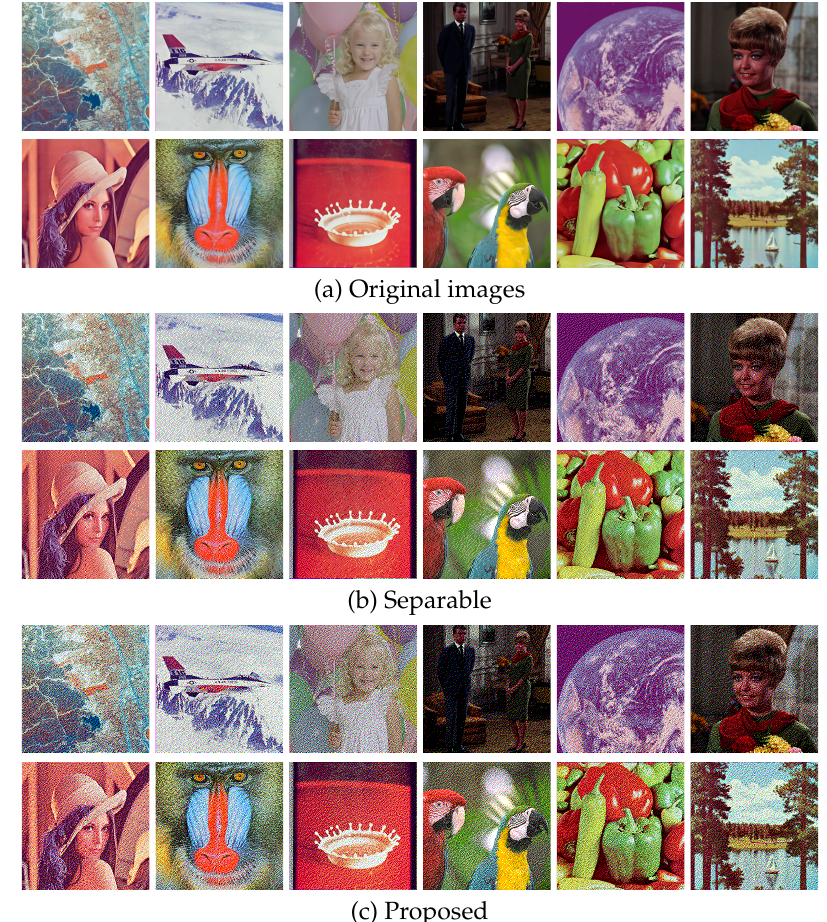
Figure 10. Results on the SIDBA images.